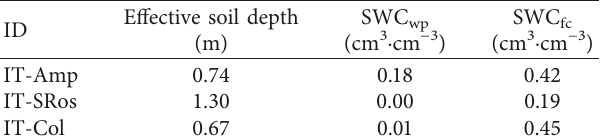
Figure 3: Annual evolutions of daily precipitation (PREC) and potential evapotranspiration (ET (b), and measured and estimated ET A (c) for Amplero (all correlations are highly significant, P < 0 . Table 3: ESD and SWC corresponding to null and full RET identified by the described methodology in the three study sites.